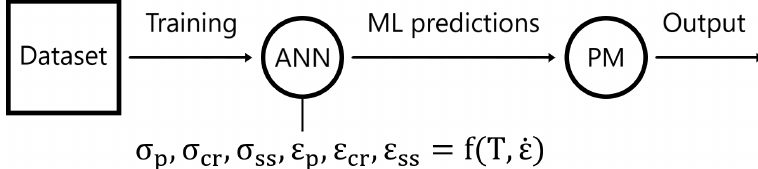
Figure 3. Schematic of the hybrid model (HM). ANNs was trained to predict the characteristic points (critical, peak, steady state stress and strain) as functions of temperature (T) and strain rate (˙ ε ). These predictions are used as input for the phenomenological model, which outputs the final flow curves.